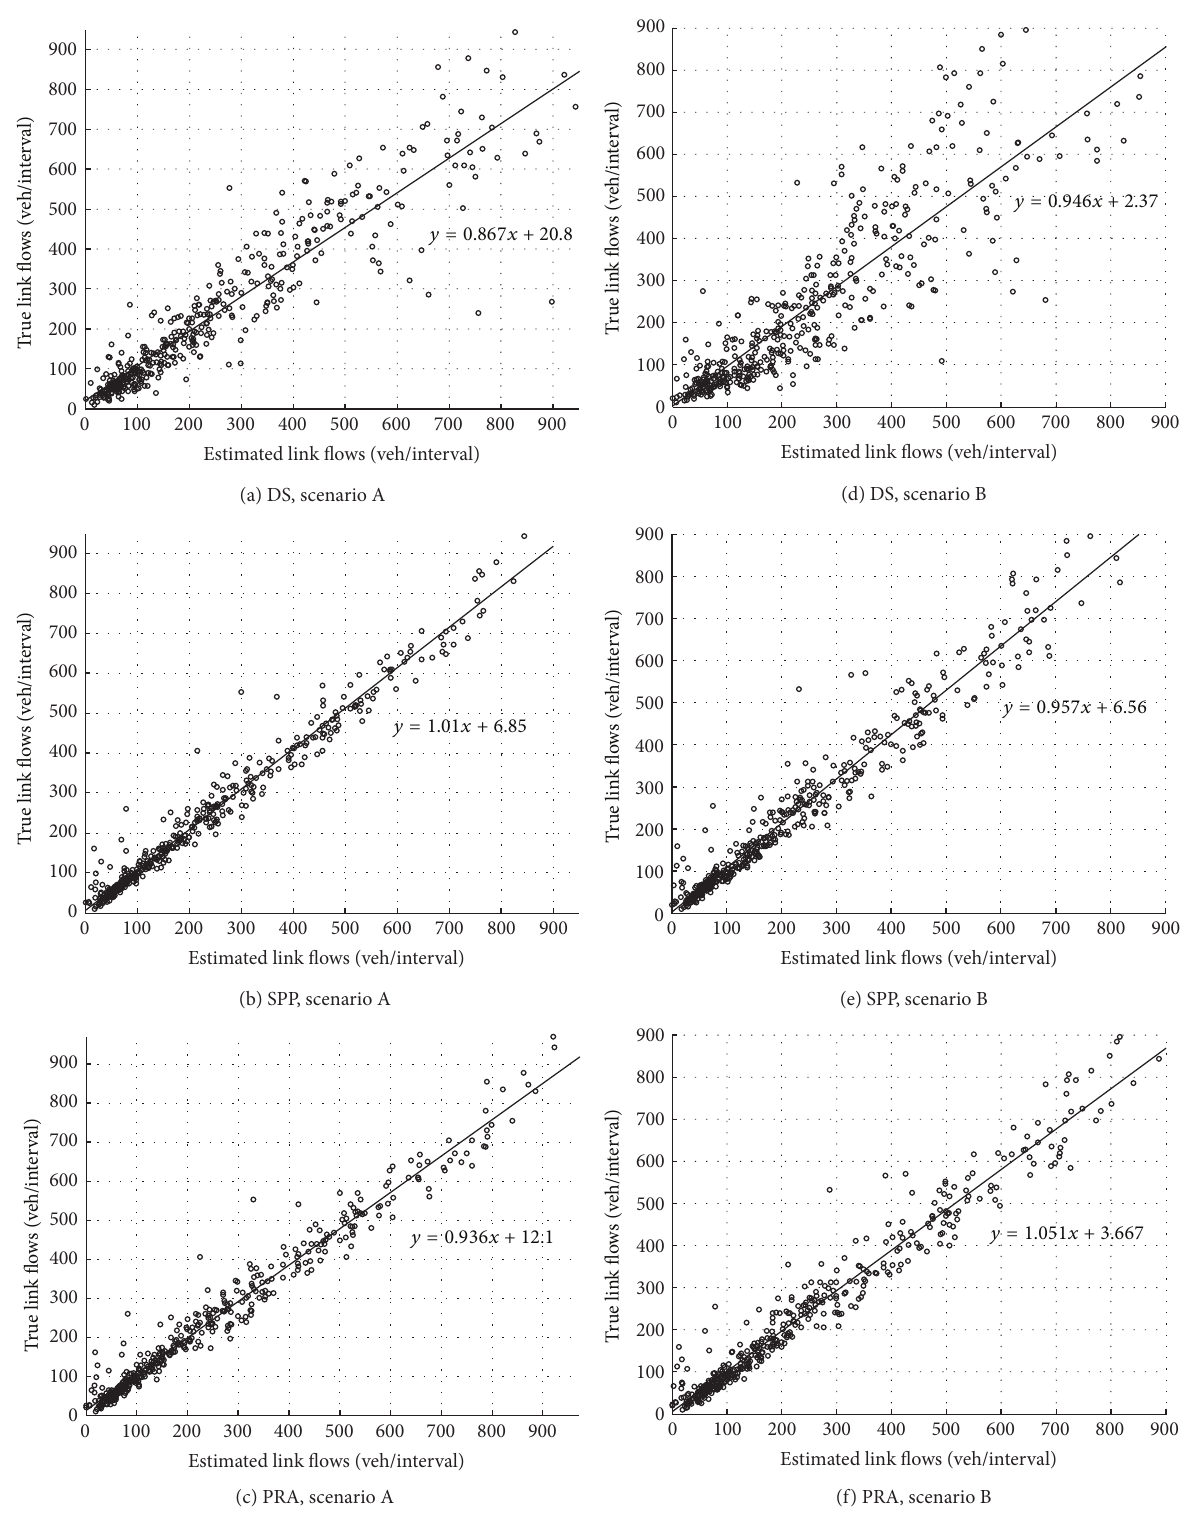
Figure 6: Scatter plots of estimated and observed link flow